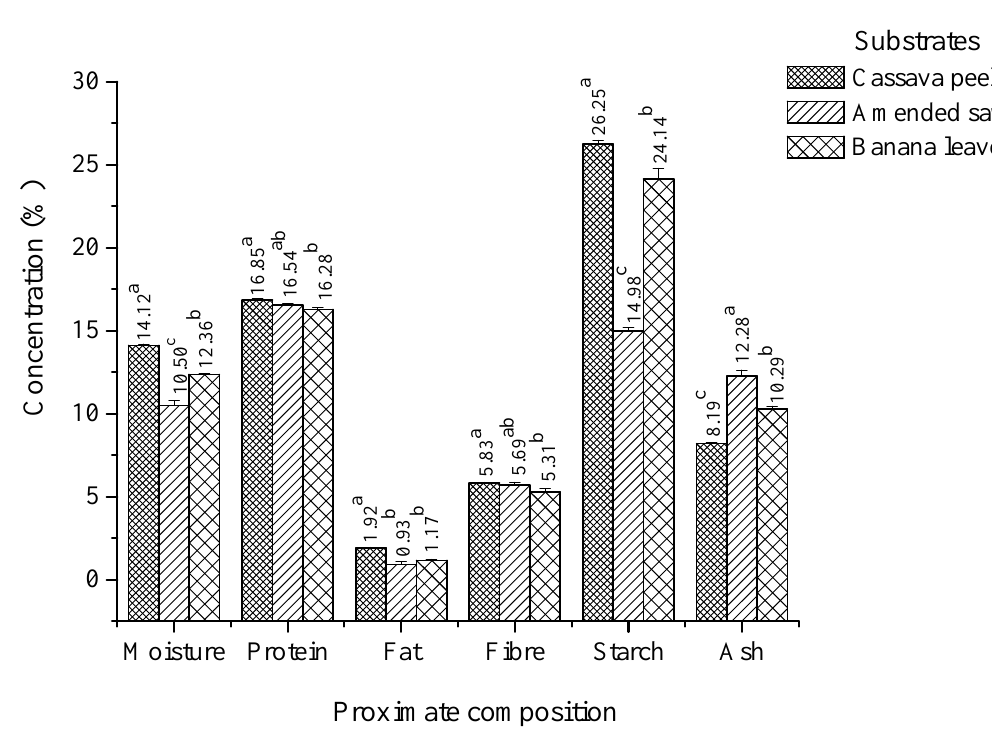
Figure 1: Proximate analysis of Pleurotus pulmonarius as influenced by